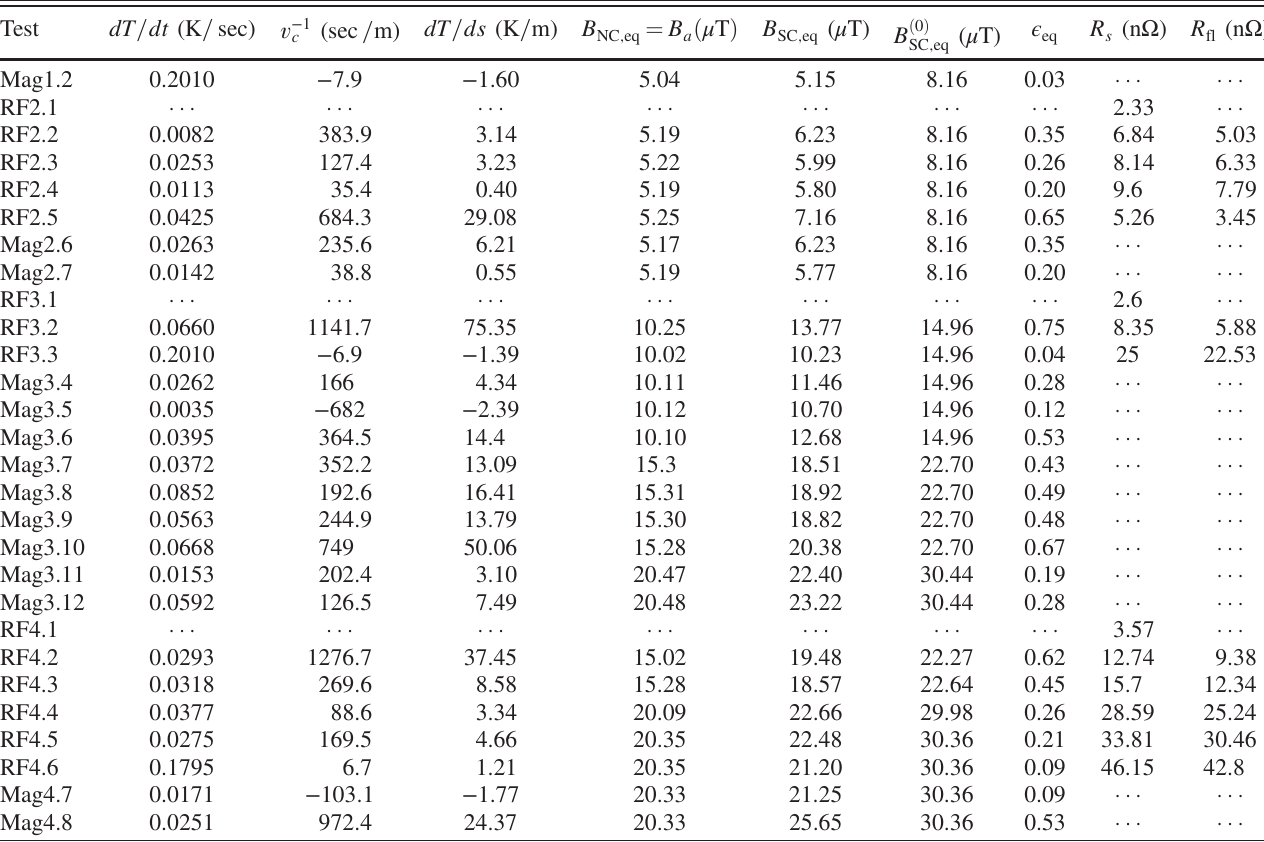
TABLE I. Summary of results.